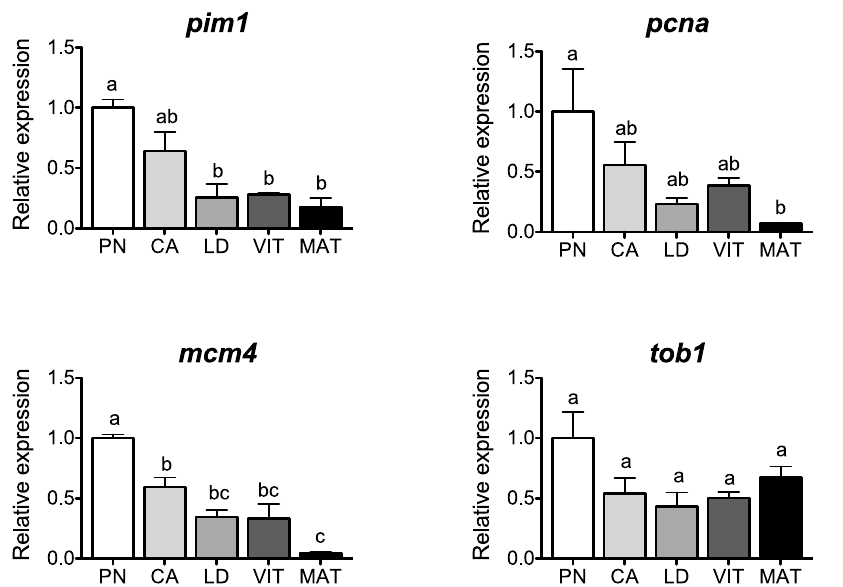
Fig. 6. Expression profiles of genes associated with cell proliferation during major stages of oogenesis in coho salmon. Messenger RNA levels were analyzed by qPCR and data were normalized to the geometric mean of four reference genes ( eef1a , ctsd , ctsz and actb ). PN, perinucleolus stage follicles; CA, cortical alveolus stage follicles; LD, lipid droplet stage follicles; VIT, mid-vitellogenic stage follicles; MAT, postvitellogenic/preovulatory stage follicles. Bars not sharing the same letter are significantly different (P , 0.05; n 5 4 fish/stage for PN-, CA-, LD-, and VIT-stages, n 5 3 fish for MAT-stage, mean ¡